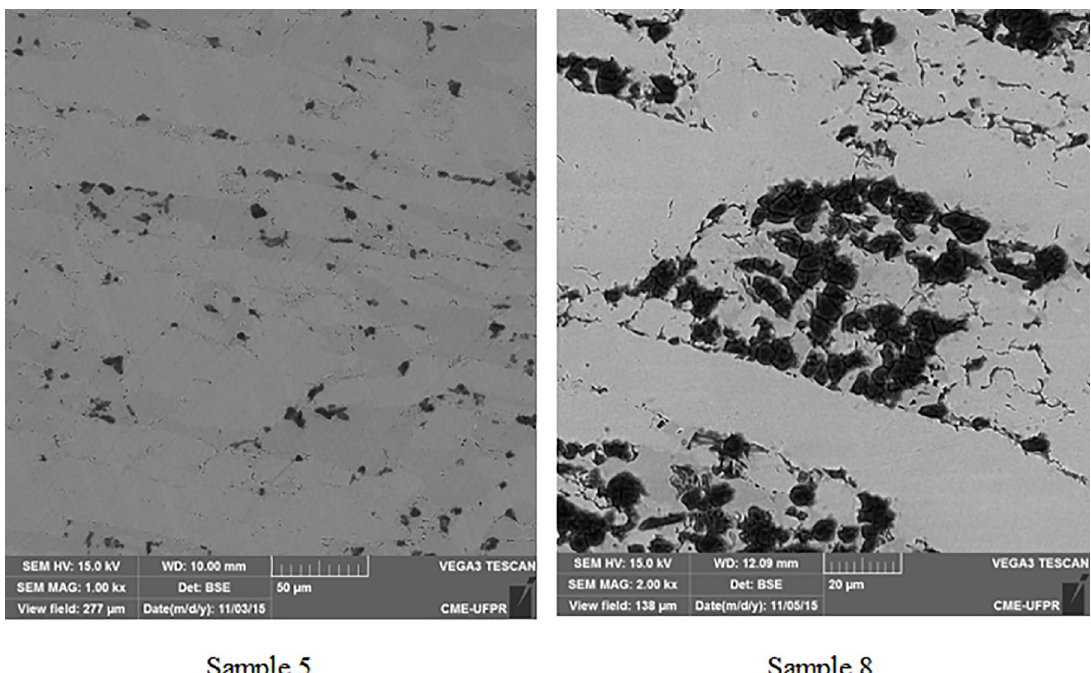
Figure 4. Microstructure of UNS S 31803 steel and different conditions of thermal treatment by SEM. Etching with 10% KOH, 2 V and 60